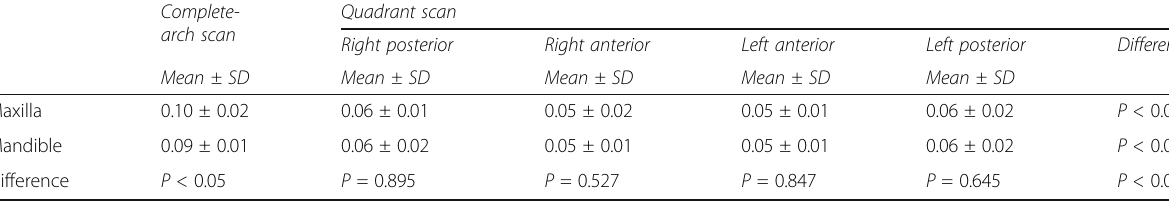
Table 1 Average surface difference with reference model scan in each complete-arch scan and quadrant scan (mm) Complete- arch scan